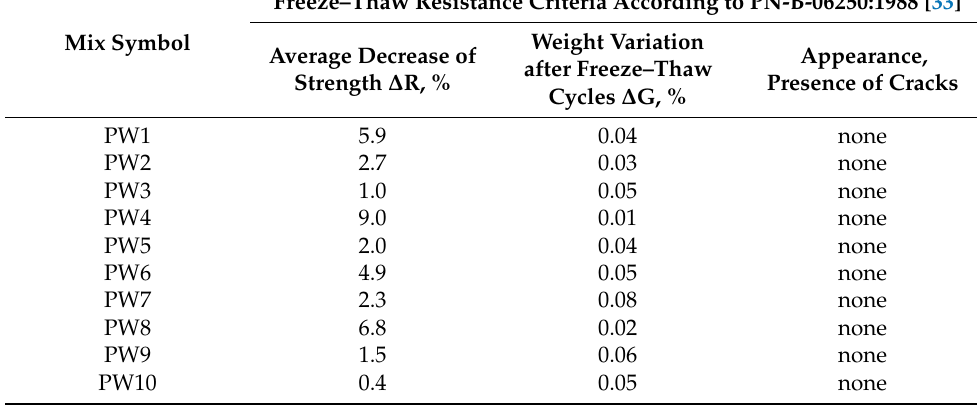
Table 4. Results of the F25 freeze–thaw test carried out on the tested concrete